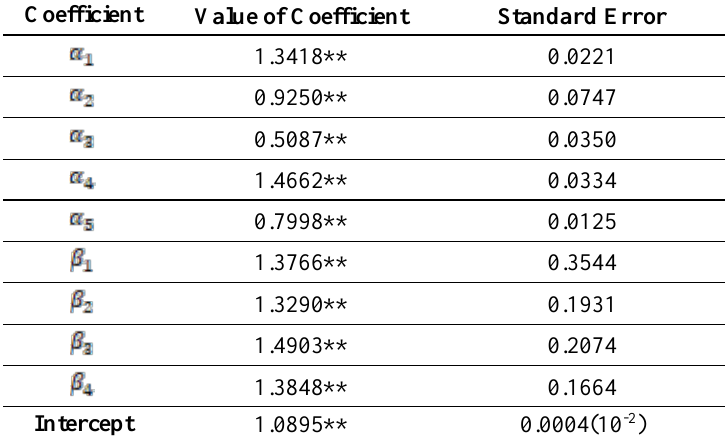
Table.2. Result of GARCH